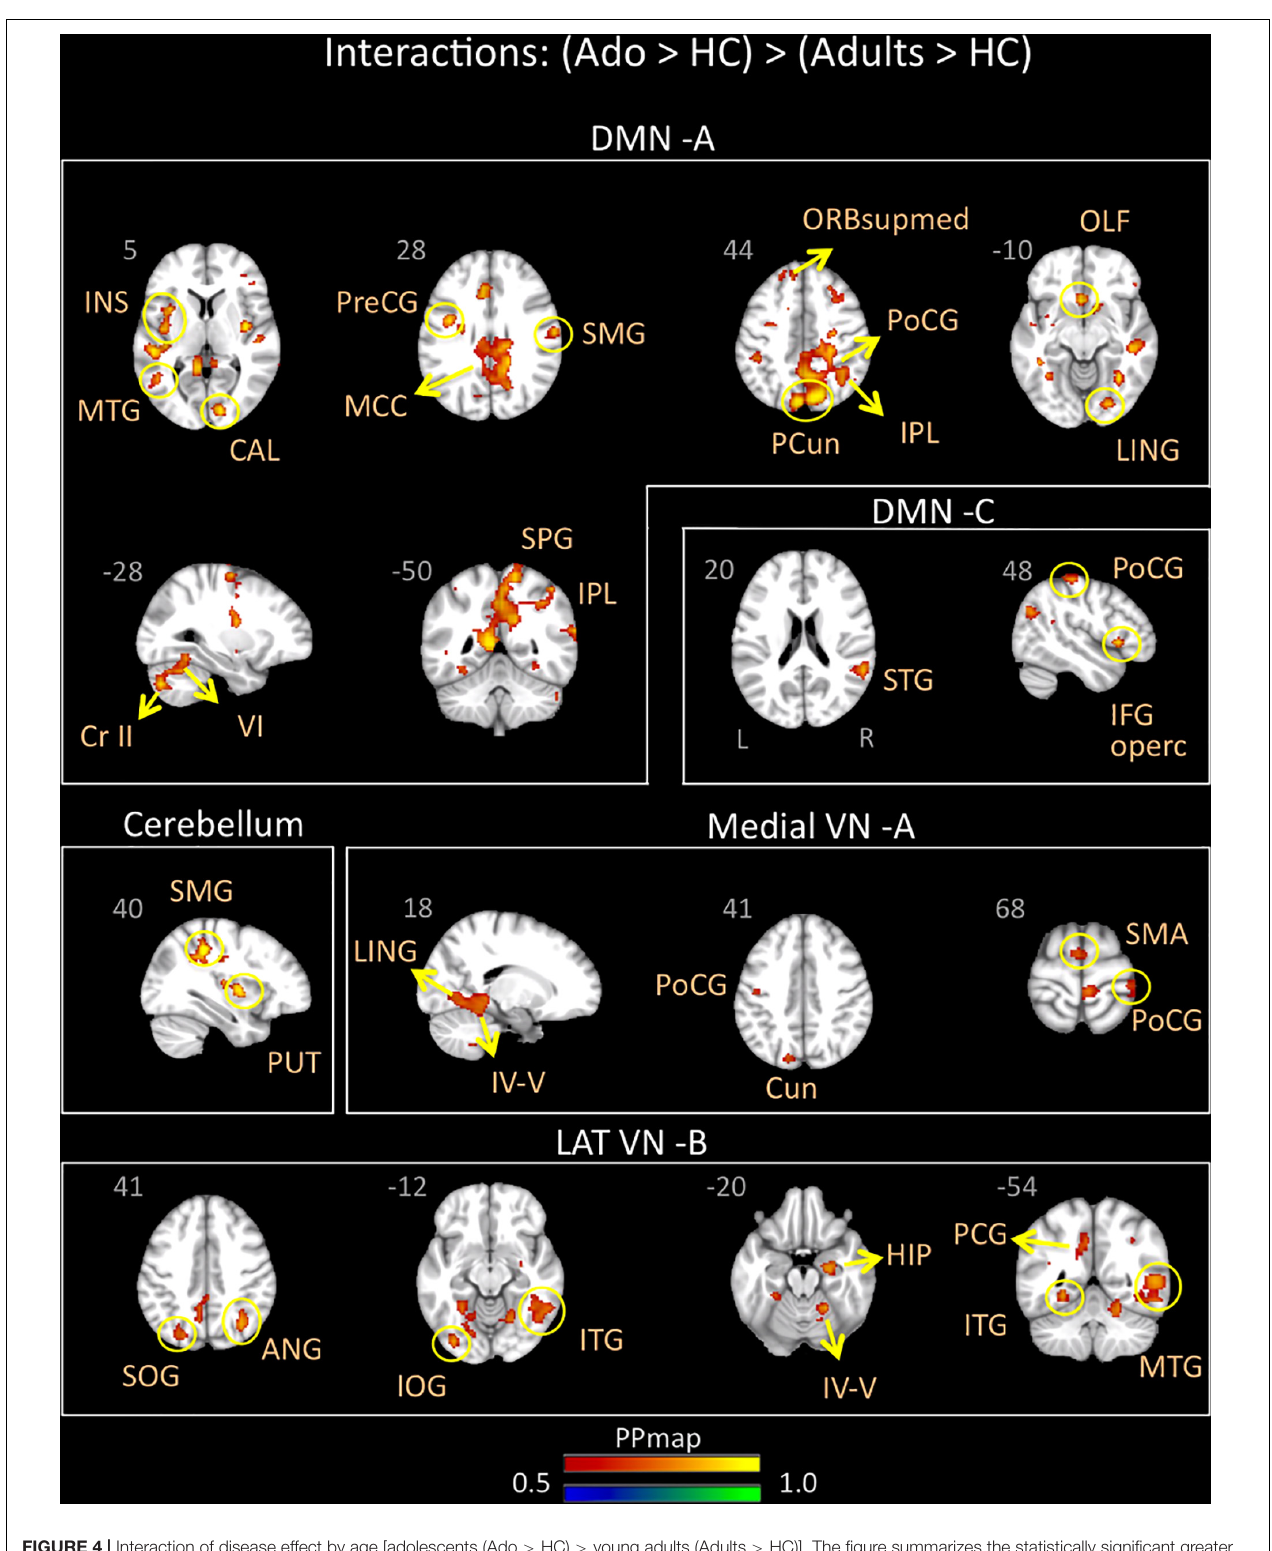
FIGURE 4 | Interaction of disease effect by age [adolescents (Ado > HC) > young adults (Adults > HC)]. The figure summarizes the statistically significant greater rs-FC in adolescents with migraine in comparison to young adults with migraine and their healthy controls. Greater connectivity was found in the default-mode A and C, cerebellum, medial visual A, and lateral visual B networks. See text for further details and Table 6 . Numbers refer to the standard MNI Atlas coordinates. Abbreviations of brain regions are described in Table 8 . Red – Yellow: increased connectivity in adolescents migraineurs vs. young adults migraineurs. Blue – Green: Decreased connectivity in adolescents migraineurs vs. young adults